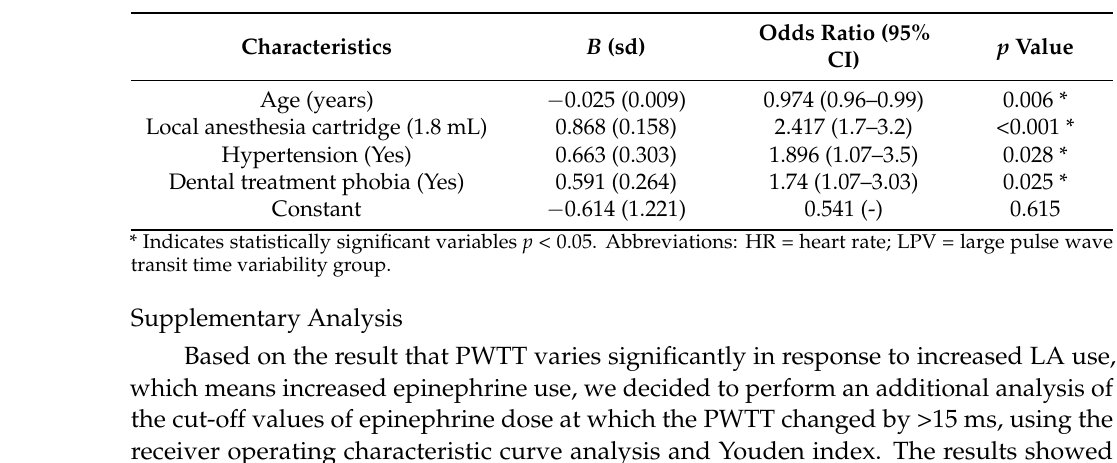
Table 4. Logistic regression analysis on clinical characteristic toward